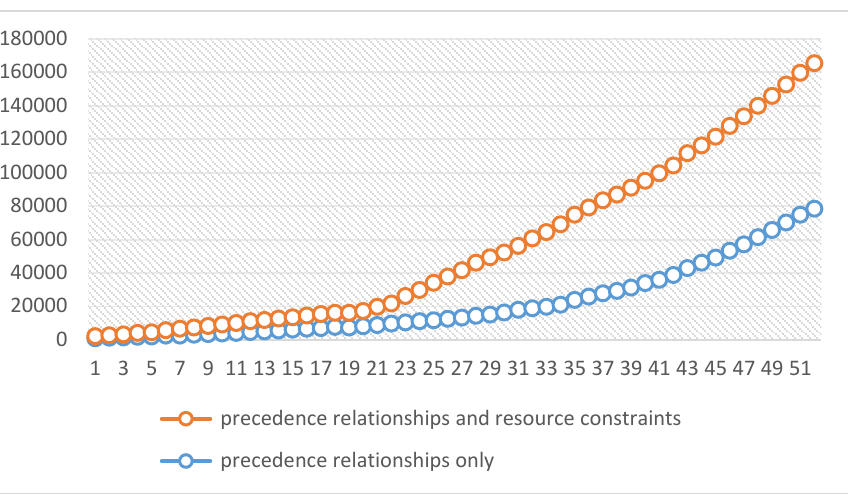
Figure 17. Optimal cost values for two considered scenarios.